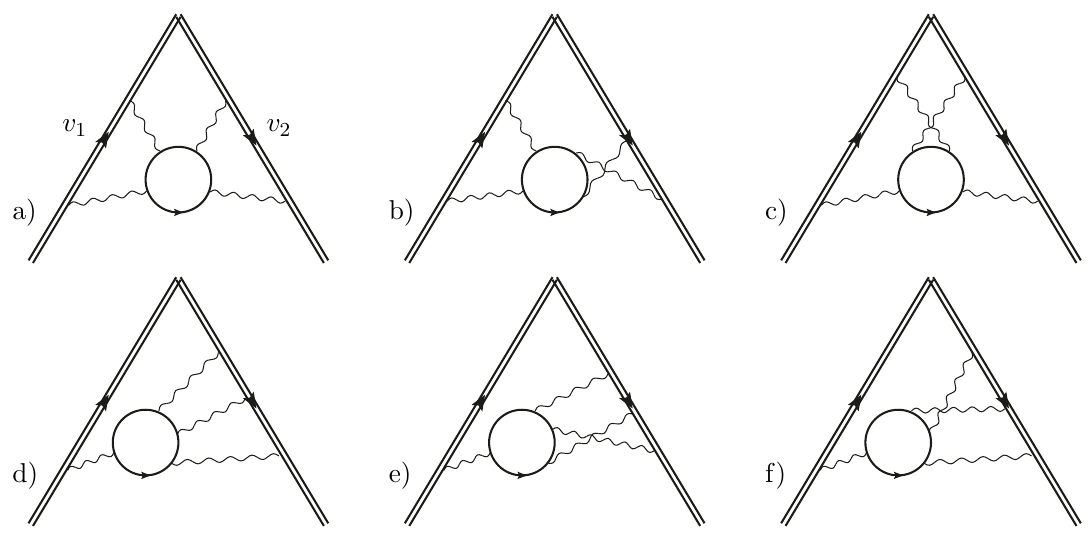
Figure 1 . Diagrams contributing to the n f C F; 4 term in the vertex function V ( (cid:30) ). Double lines rep- resent Wilson lines, wavy lines gluons and single lines the n f light quarks. Left-right mirror graphs and the diagrams with reversed light fermion (cid:13)ow are not displayed. The n f C F; 4 contributions of the latter equal the ones of their relatives shown